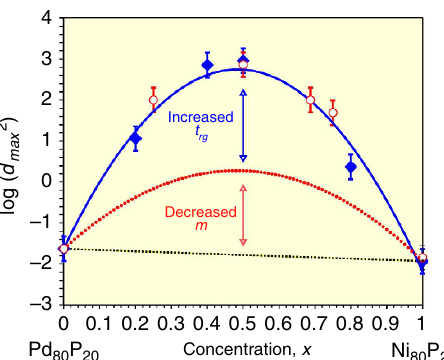
Figure 4 | GFA versus composition diagram for the pseudobinary (Pd 1 (cid:2) x Ni x ) 80 P 20 system. Input data are taken from refs 25–32. Solid blue square symbols are calculated GFA from experimental t rg and m values 31,32 using equation (2). The solid blue line is a fit to the calculated GFA values. Dotted red line is a parabolic fit to the calculated contribution from fragility. Red open circles are experimental GFA data from refs 25–30. The reader is referred to the Supplementary Information for details. Error bars represent experimental uncertainty of 15% in the maximum casting diameter as discussed in